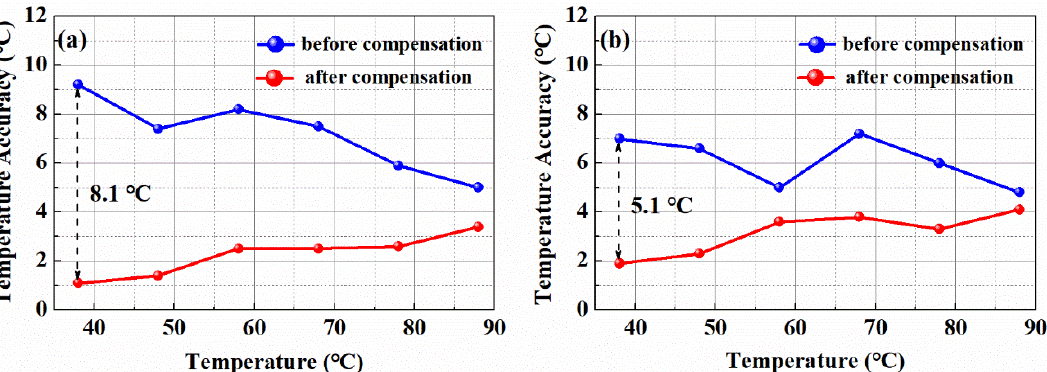
Figure 7. ( a ) Temperature measurement accuracy before and after optical power compensation at FUT 2 (9.6 km); ( b ) Temperature measurement accuracy before and after optical power compensation at FUT 3 (18.27 km).